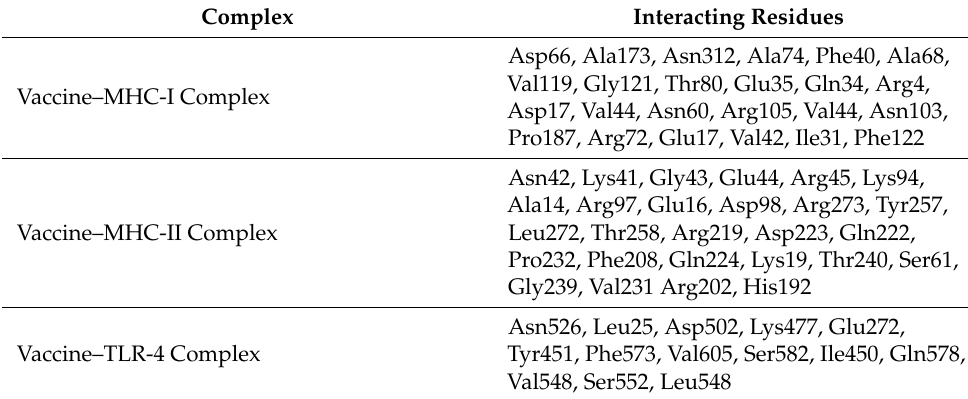
Table 3. Vaccine–immune receptor interacting residues within 5